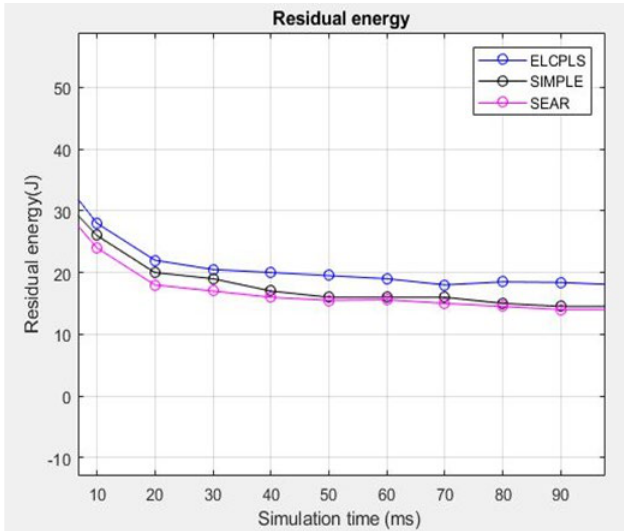
Figure 16. Residual energy in WBAN